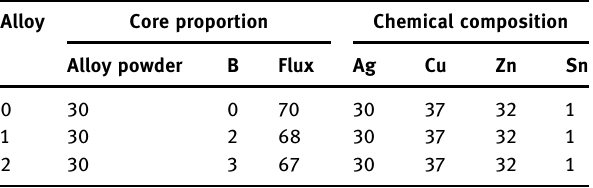
Table 1: Chemical composition of the BAg30T fi ller metal ( wt%